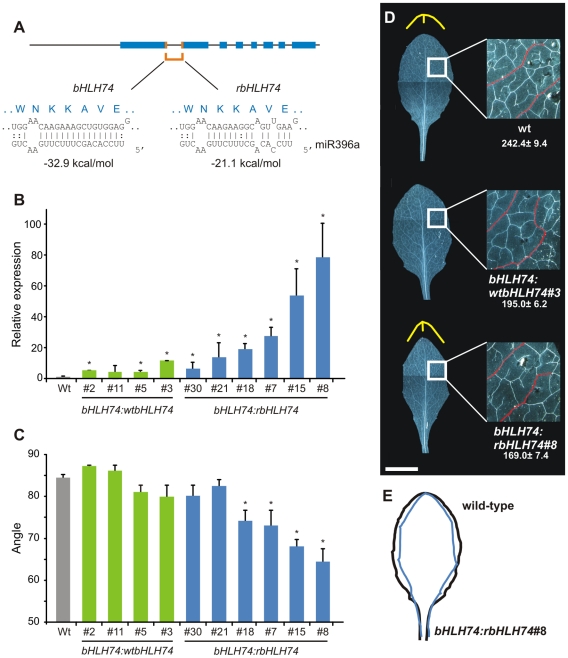
Characterization of transgenic plants expressing a miR396-resistant bHLH74.(A) Schematic representation of bHLH74 and rbHLH74 constructs. (B) bHLH74 transcript levels estimated by RT-qPCR in mature leaves of plants expressing a wild-type (bHLH74:wtbHLH74) or miR396-resistant (bHLH74:rbHLH74) form of the gene encoding the transcription factor. Data shown are mean ± SEM of 3 biological replicates. Asterisks indicate significant differences between transgenic and wild-type plants, as determined by ANOVA (P<0.05). (C) Angle determination at the distal tip of leaf #5 in transgenics depicted on panel (B). Asterisks indicate significant differences between transgenics and wild-type plants, as determined by ANOVA (P<0.05). (D) Morphology of fully-expanded leaf #5. The different angles at the distal edge of the leaf are highlighted in yellow for wild-type and bHLH74:rbHLH74 leaves. An inset on the right shows the difference in venation (secondary veins are highlighted in red), with the number of branching points (NBP) indicated below. Data shown are mean ± SEM of 8 biological replicates. Scale Bar: 1 cm. (E) Scheme highlighting differences in leaf edges of wild-type and miR396-resistant bHLH74 plants.